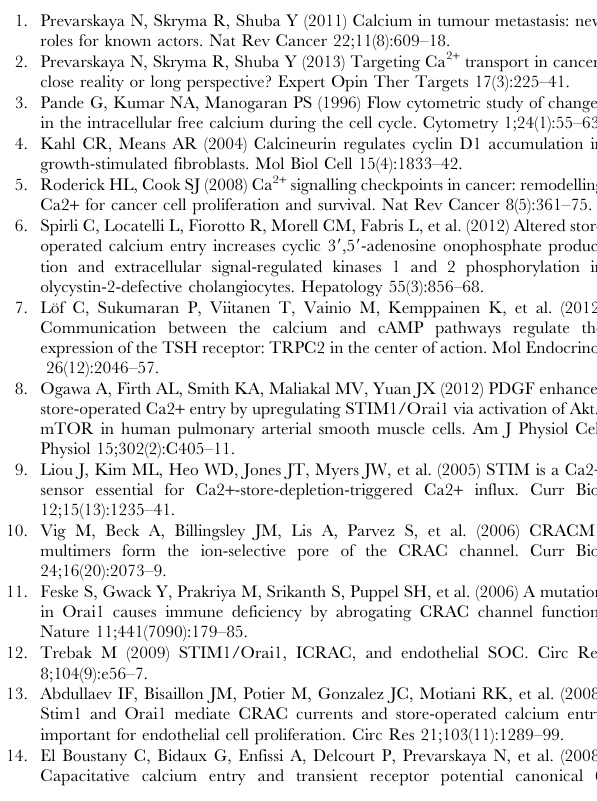
Figure S1 Orai-1 and Orai-2 mRNA determined in NCI- H23 (A) and NCI-H460 (B) cells transfected with si-Orai1 (i), si-Orai2 (ii), or si-CTL using Q-PCR. Si-Orai1, as well as si-Orai2 decreased the Orai1 or Orai2 transcript levels normalized to b -actin in NCI-H23 (A) and NCI-H460 (B) (n= 2, * p , 0.05, ** p , 0.01, *** p , 0.001, Mann-Withney test). (TIF) Figure S2 Orai3 mRNA (i) and protein (ii) levels in NCI- H23 (A) and NCI-H460 (B) cells transfected with si-CTL and si-Orai3, as determined by Q-PCR and Western blot. Si-Orai3 decreased Orai3 transcript and protein levels normalized to b -actin in NCI-H23 (A) and NCI-H460 (B) (n= 3, p , 0.001, Mann-Withney test). Orai-1 mRNA (i) and protein (ii) levels detected by Q-PCR and Western blot in NCI-H23 (C) and